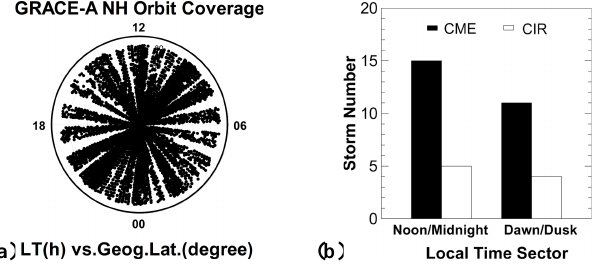
Fig. 1. (a) The local time and latitude coverage of the GRACE-A satellite orbits for the considered storms; (b) histogram of the local time sector (noon/midnight or dawn/dusk) for CME and CIR.